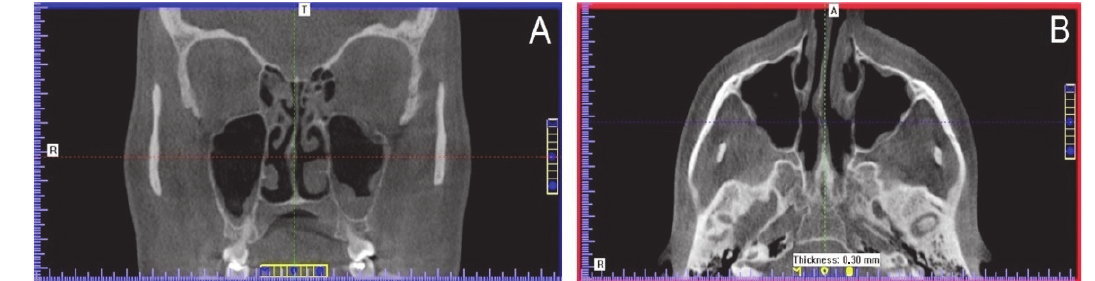
Figure 5. Image of maxillary sinuses after 30 sessions of electromagnetic field and LED light therapy. ( A ) coronal view; ( B ) axial view. (CBCT scans).